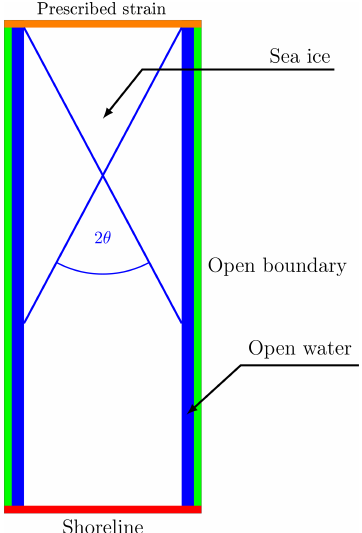
Figure 2. Model domain with a solid wall on the southern (red) boundary (Dirichlet boundary conditions with u = 0) and pre- scribed southward velocities on the northern orange boundary ( u = 0, v = a v · t + v i ; Eq. 15) and open boundaries to the east and the west (green) with von Neumann boundary conditions. θ is the mea- sured fracture angle with the blue line representing an LKF.